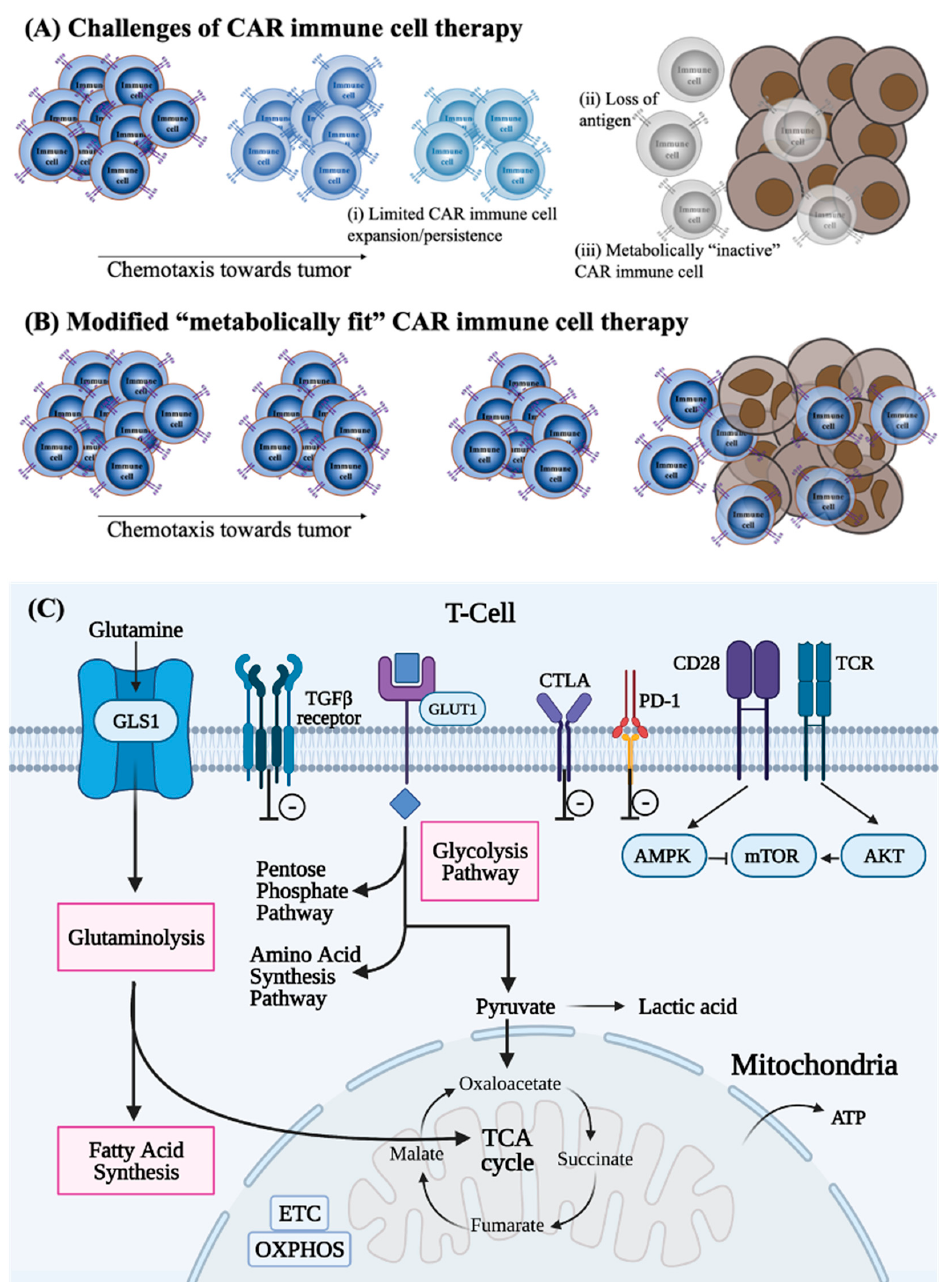
Figure 2. Metabolically fit chimeric antigen receptor (CAR) cells need to be generated for effective CAR immunotherapy. ( A ) When CAR immune cells reach their target, due to the paucity of nutrients, these cells can become exhausted. This prevents the CAR immune cells from functioning and allows for tumor growth. ( B ) Metabolically fit CAR immune cells can be generated by modifying the metabolic pathways that endow these immune cells to out-compete cancer cells for nutrients and thus remain active even in the TME for the eradication of cancer cells. ( C ) Metabolic pathways that are disrupted and can be modified to generate metabolically fit CAR-immune cells.